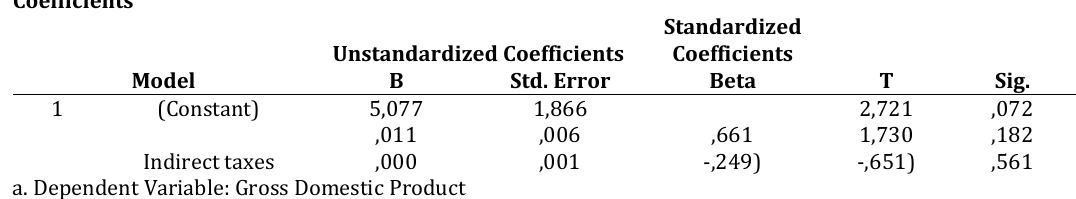
Table7: The importance of variables in the model based on the p-value of the coefficients